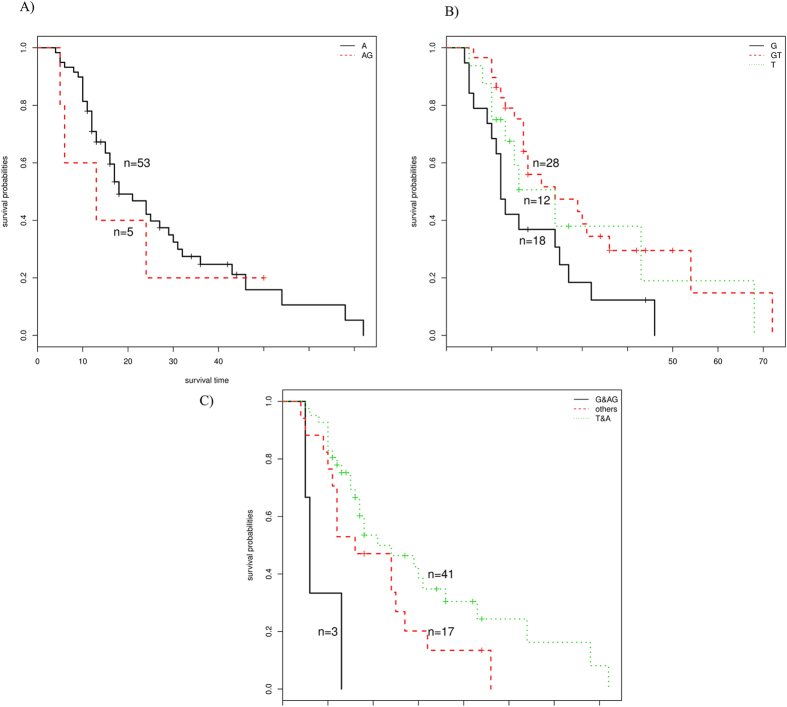
Stepwise regression analysis results of SNP rs2279744 (MDM2) and rs2909430 (TP53) in adenocarcinoma patients.(A) rs2909430(TP53) (B) rs2279744(MDM2) (C) Conjoint analysis of rs2909430(TP53)and rs2279744(MDM2).